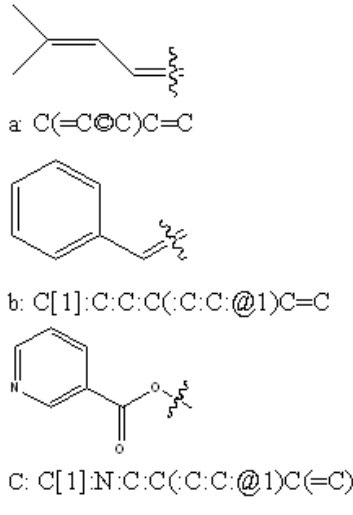
Figure 3. Key fragments of 2D-QSAR